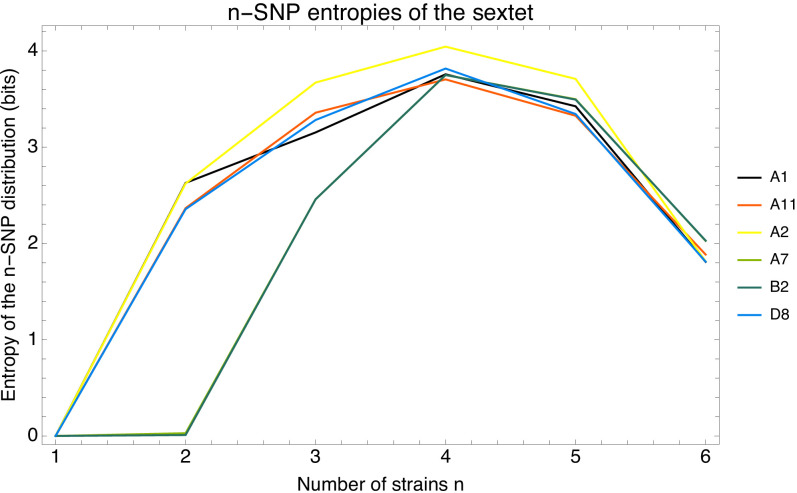
Entropy profiles for the six strains (A1, A2, A7, A11, B2, D8).